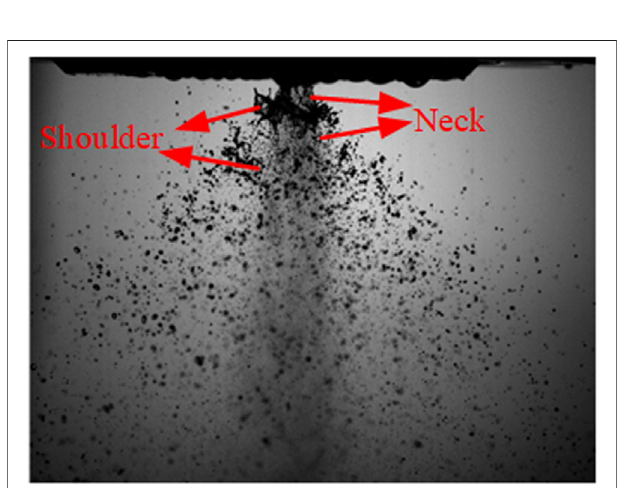
FIGURE7| Self-pulsationsprayattherecesslengthof7 mm( m l (cid:2) 20 g/ s, mg (cid:2) 3.6 g/s).